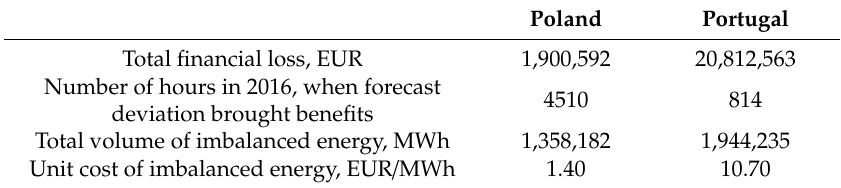
Table 4. Financial losses resulting from wind generation forecast deviation in